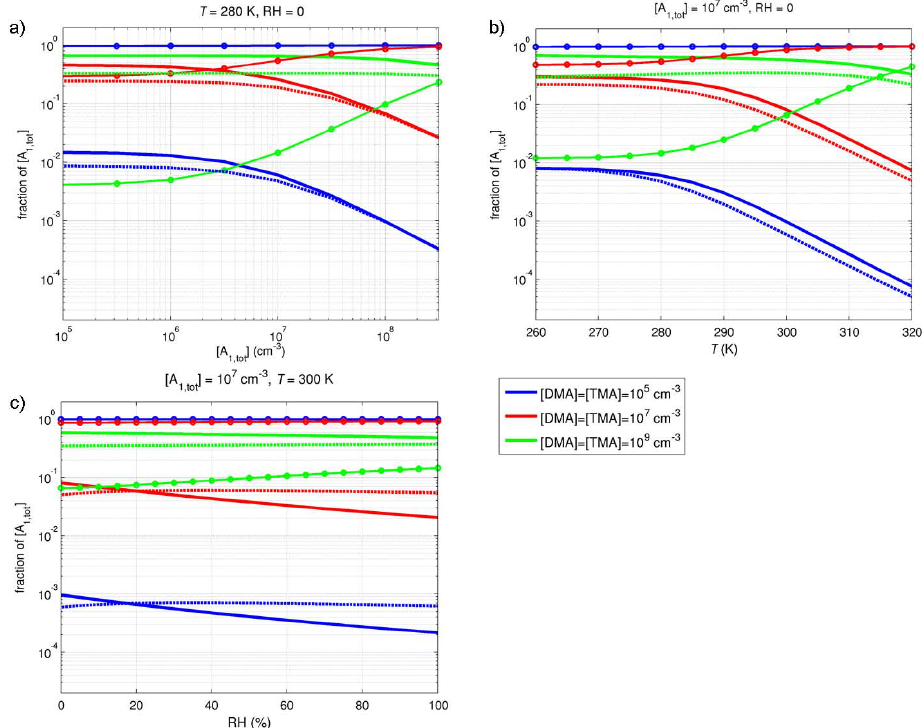
Fig. 2. Contributions of pure A (solid lines with circles), A 1 T 1 -cluster (solid lines) and A 1 D 1 -cluster (dashed lines) to the total H 2 SO 4 monomer concentration [A 1 , tot ] at varying amine concentrations (a) as a function of the total H 2 SO 4 monomer concentration, (b) as a function of temperature and (c) as a function of relative humidity (RH). Temperatures, RHs and total sulphuric acid monomer concentrations in the model runs are shown in the